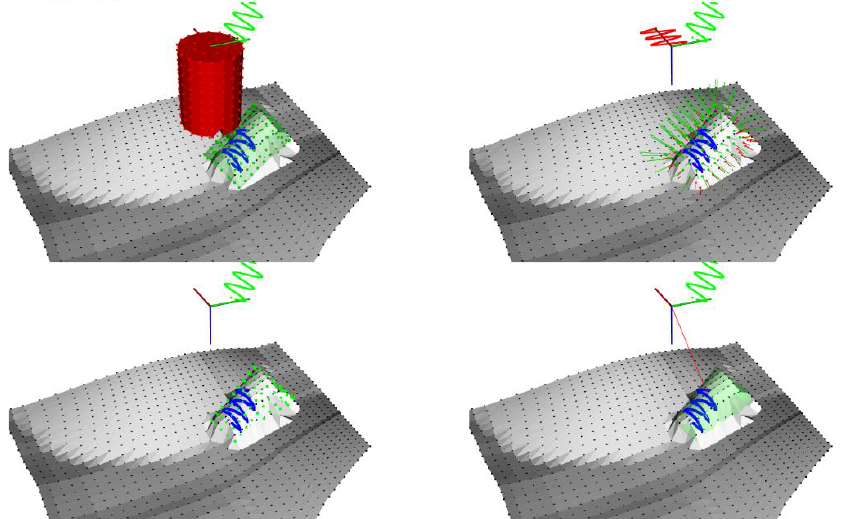
Figure 6. A graphical interface displays the processes of object identification and overlaying a working tool trajectory onto the object surface.